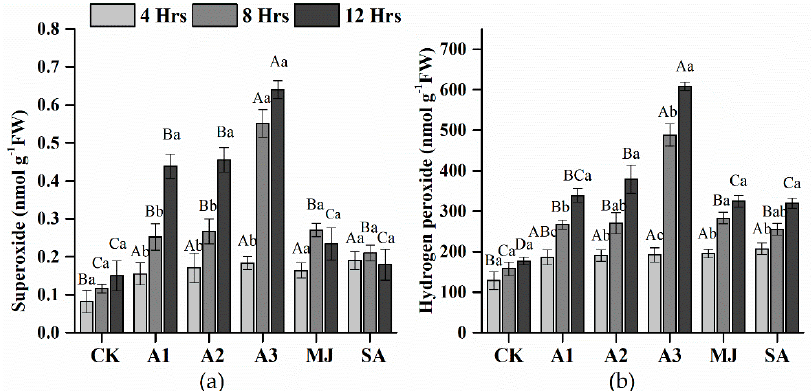
Figure 5. Effect of AGE, MeJA, and SA on the ROS concentration in eggplant seedlings. ( a ) Superoxide, ( b ) Hydrogen peroxide. Ck (distilled water), A1, A2, A3 (AGE 100, 200, 300 µg mL − 1 ), MJ (MeJA 0.05 mM), SA (Salicylic acid 0.5 mM), whereas 4, 8-, and 12-h are priming durations. Bars represent mean and standard errors ( n = 4). Data were subjected to analysis of variance ANOVA. Same letters on the bars bear no significant difference at p = 0.05 (LSD), whereas, Capital letters represent significant difference among chemical treatments and small letters represent significant difference among the priming durations.